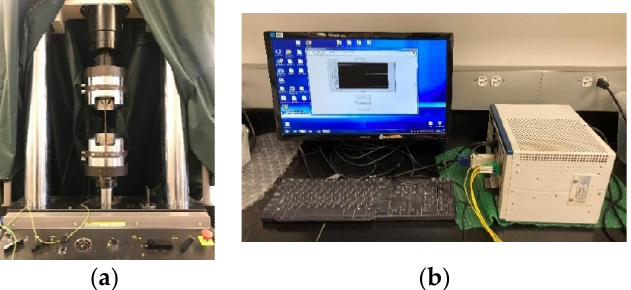
Figure 1. Calibration of strain transfer ratio: ( a ) tensile test setup and ( b ) FBG interrogator.